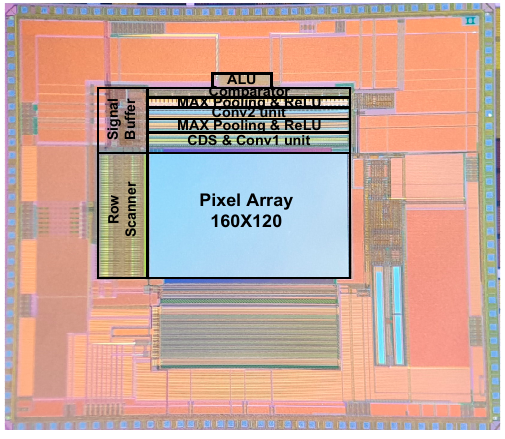
Figure 10. Chip photograph of the proposed CIS. Table 1. Performance summary of the proposed